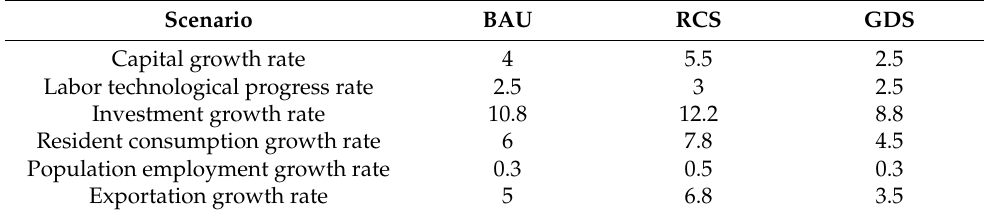
Table 3. Changing rate of shock variables in different scenarios from 2013 to 2030 (%). Scenario BAU RCS Capital growth